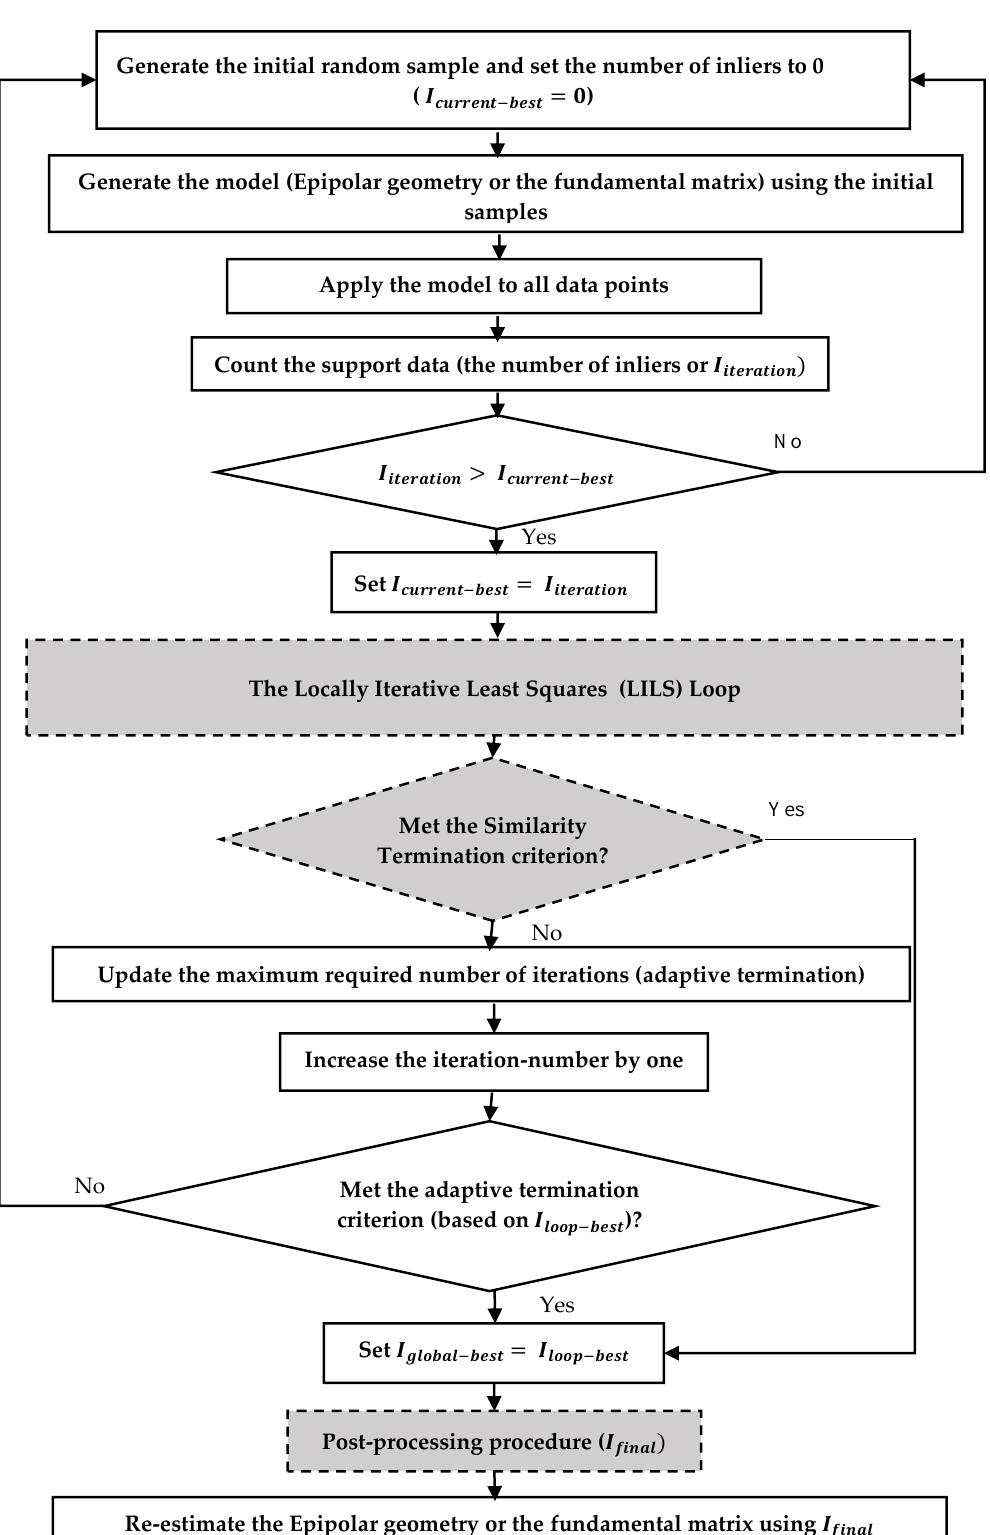
Chart 1. Processing steps in MSAC and the proposed ELISAC method (gray boxes show the three enhancements steps).